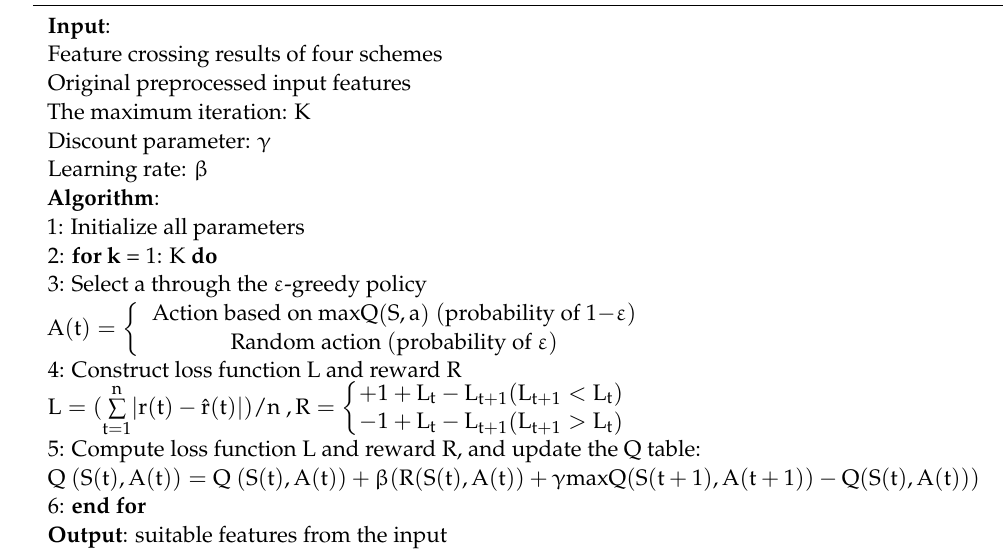
Algorithm 1 Feature Selection by